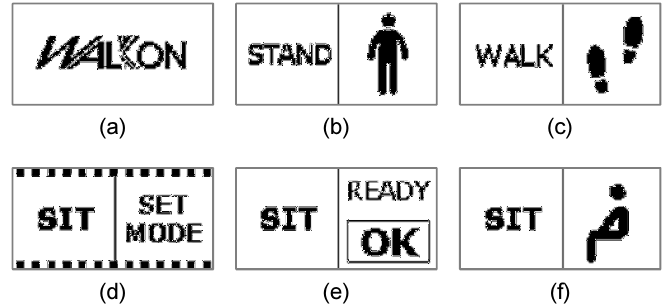
Figure 8. UI images for the OLED display in the mode selection process: ( a ) initialization process, ( b ) stand mode action, ( c ) right foot forward action in walk mode, ( d ) mode selection procedure in a sitting state, ( e ) sit mode and ( f ) sit mode